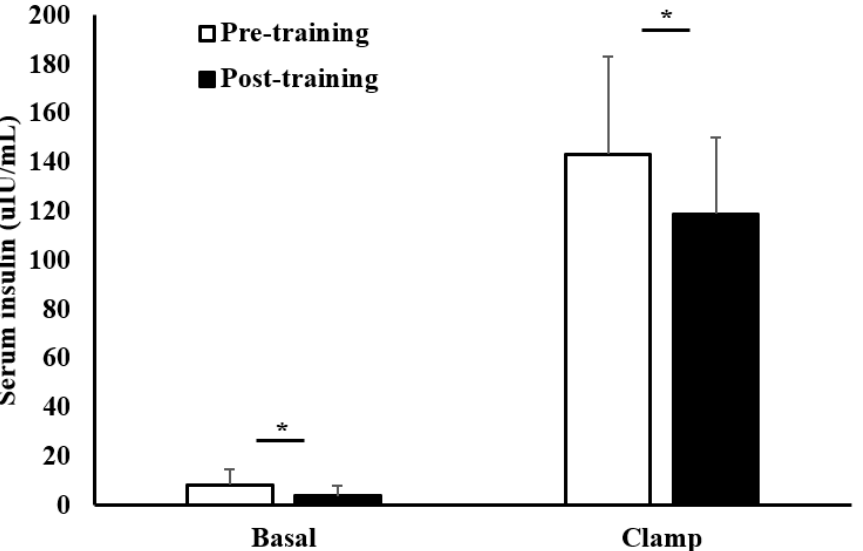
Figure 3. Fasting plasma insulin and serum insulin during the steady-state period of the clamp in the pre- versus post-training. Data are mean ± SD. * p < 0.001, paired Student’s t